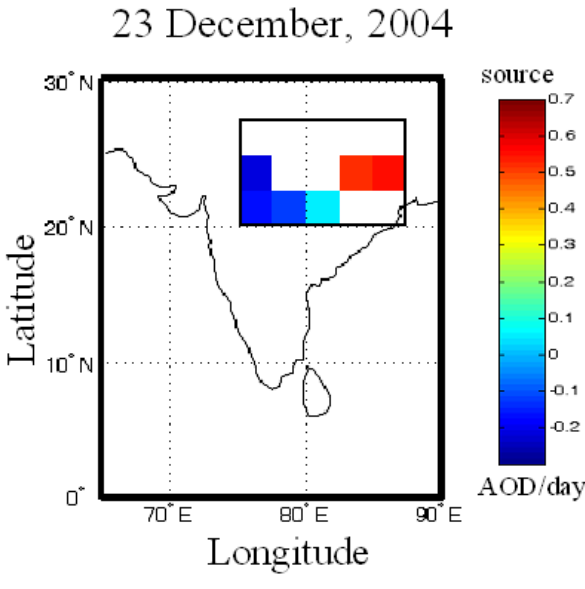
Fig. 5. Spatial distribution of source strength over the study domain on 23 December